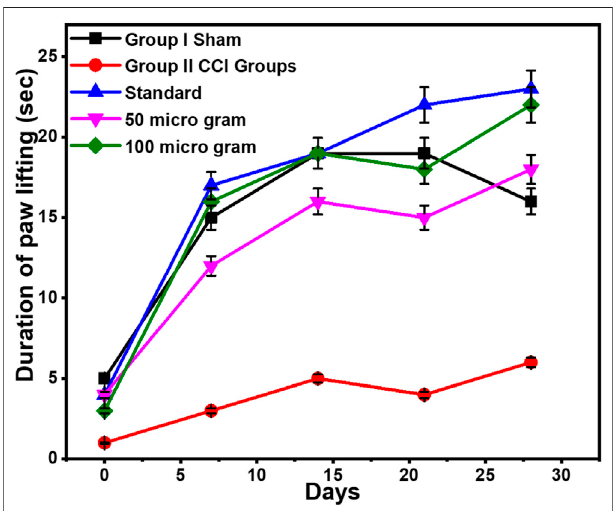
FIGURE3| Assessment ofmechanicalallodyniausing thevonFreytest. Values are expressed as mean ± SEM for six animals in each group. Signi fi cancewasdeterminedbytwo-wayanalysisofvariance. p < 0.001when compared with sham and